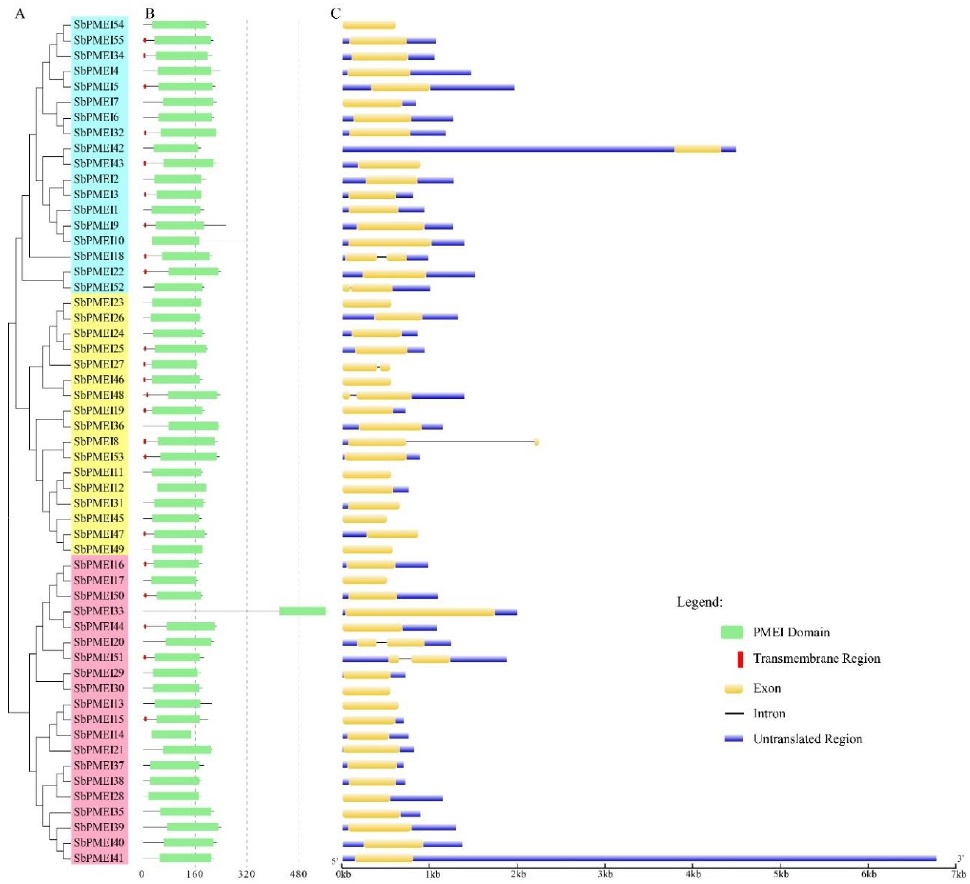
Figure 4. The NJ tree, the conserved domain in 55 SbPMEI proteins and the gene structures of sorghum 55 PMEI genes. ( A ) NJ phylogenetic tree by aligning the PMEI protein sequences of sorghum. ( B ) PMEI conserved domains (green rectangle) are presented in each PMEI proteins and transmembrane regions (red rectangle) are presented in 22 PMEI proteins of sorghum. ( C ) Gene structure of each SbPMEI . Exons and untranslated regions are presented by yellow and blue boxes, respectively. While, introns are presented by black lines.